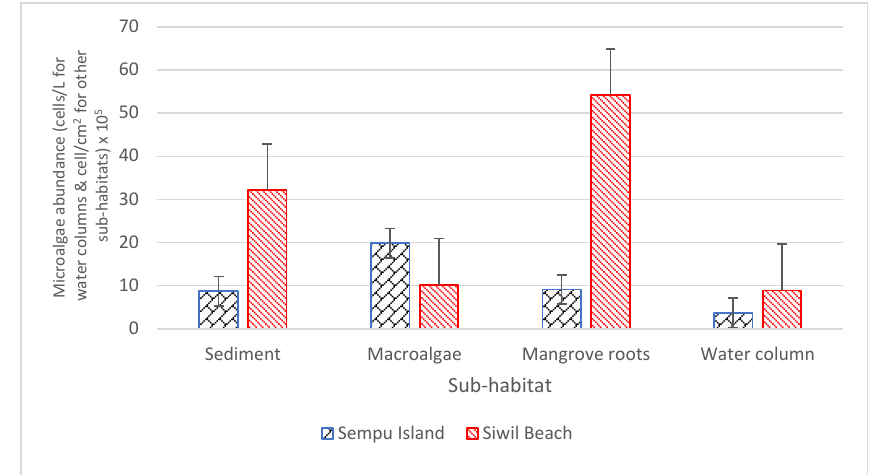
Fig. 3: Microalgae abundance at Siwil Beach and Sempu Island. Mean ± SE